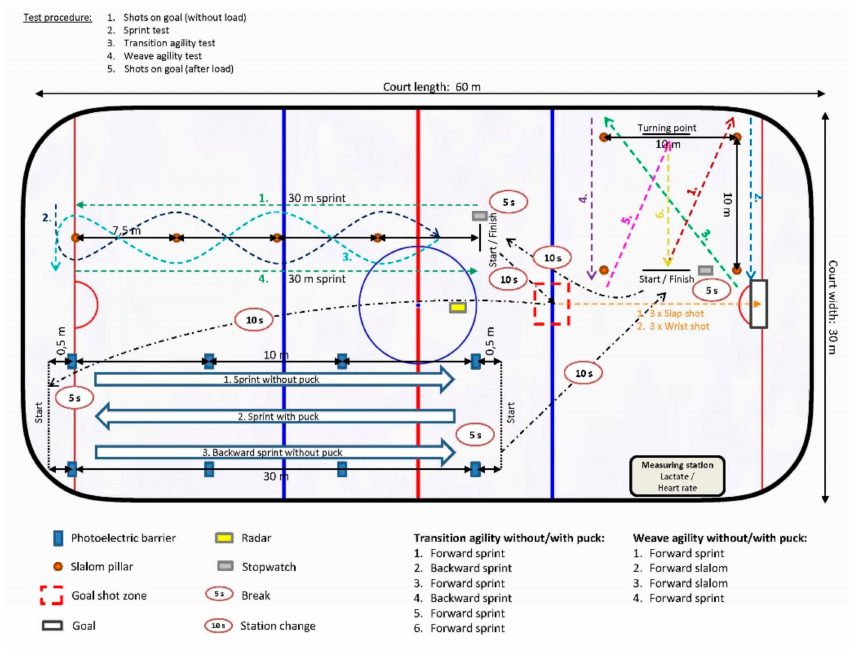
Figure 2. Schematic diagram of the IHCT and description of the test sequences